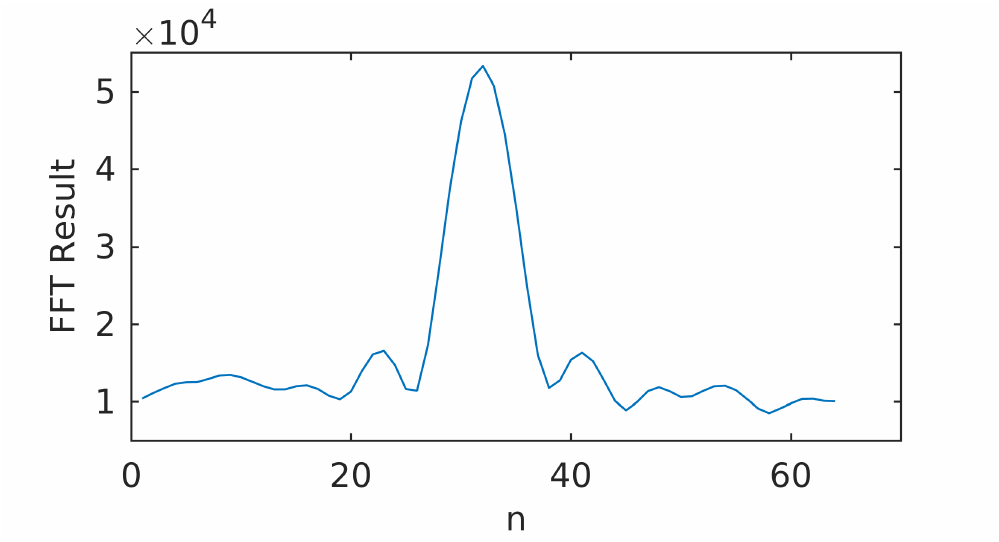
Figure 5. Non-coherent FFT